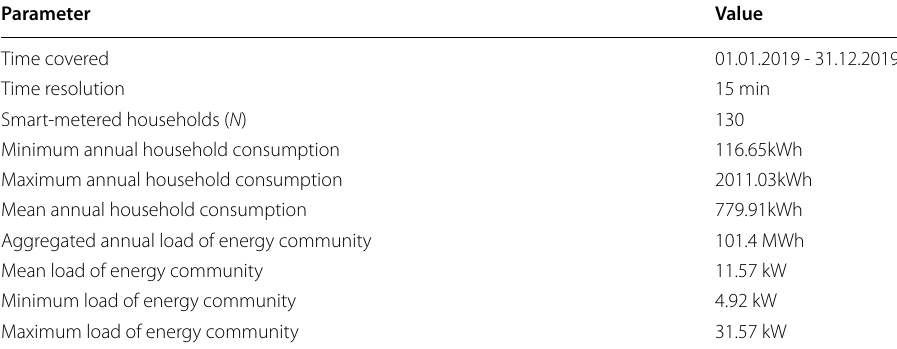
Table 4 General information and descriptive statistics about the underlying dataset Parameter